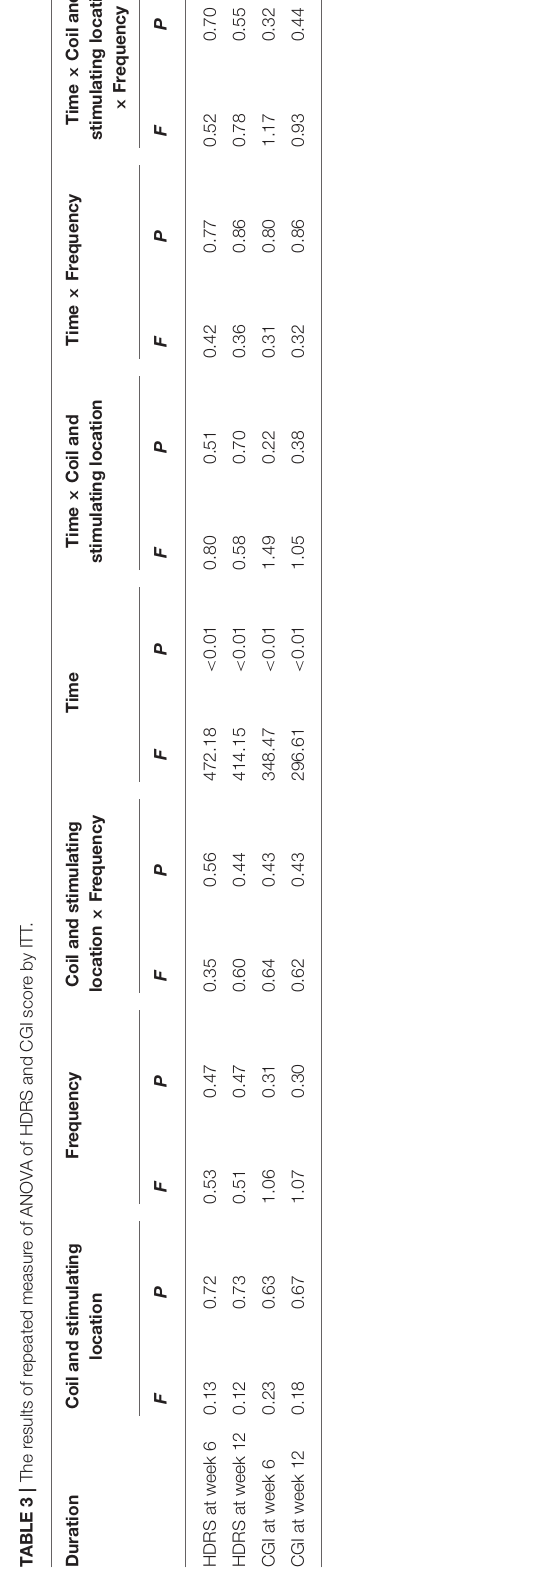
TABLE 4 | Test of within-participants contrast of response rate.